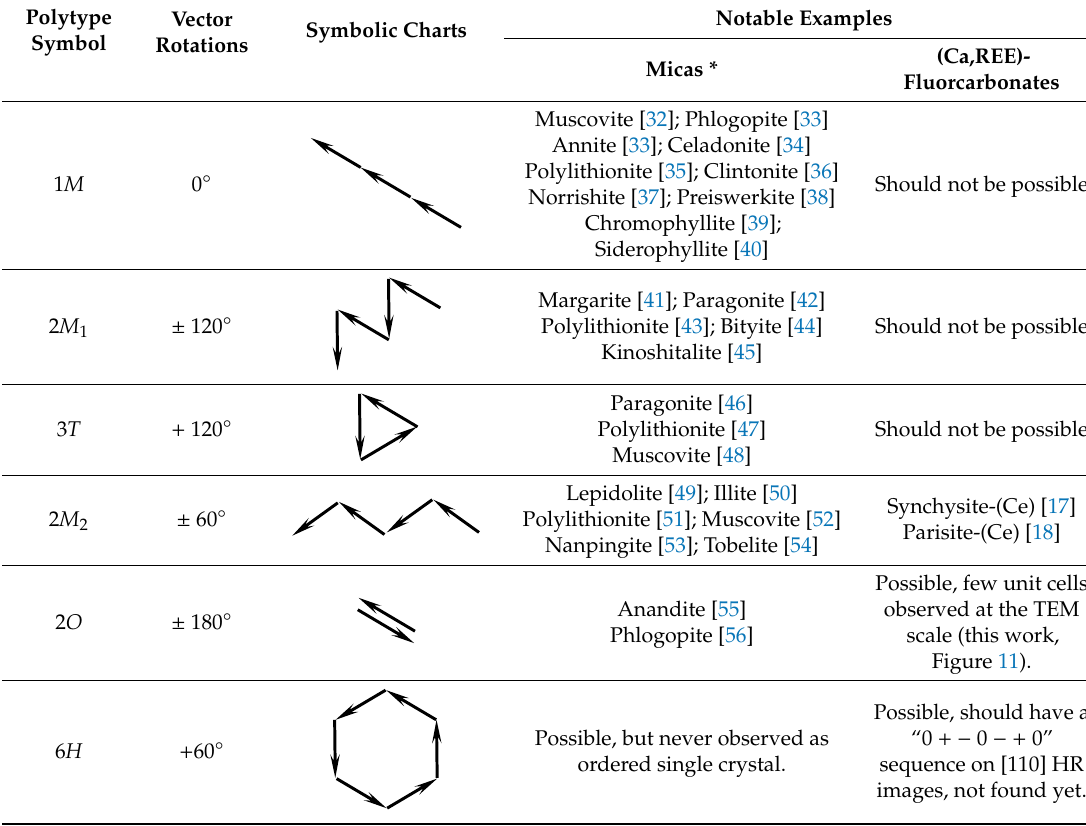
Table 5. Comparison Between Mica and (Ca,REE)-Fluorcarbonate Polytypes.